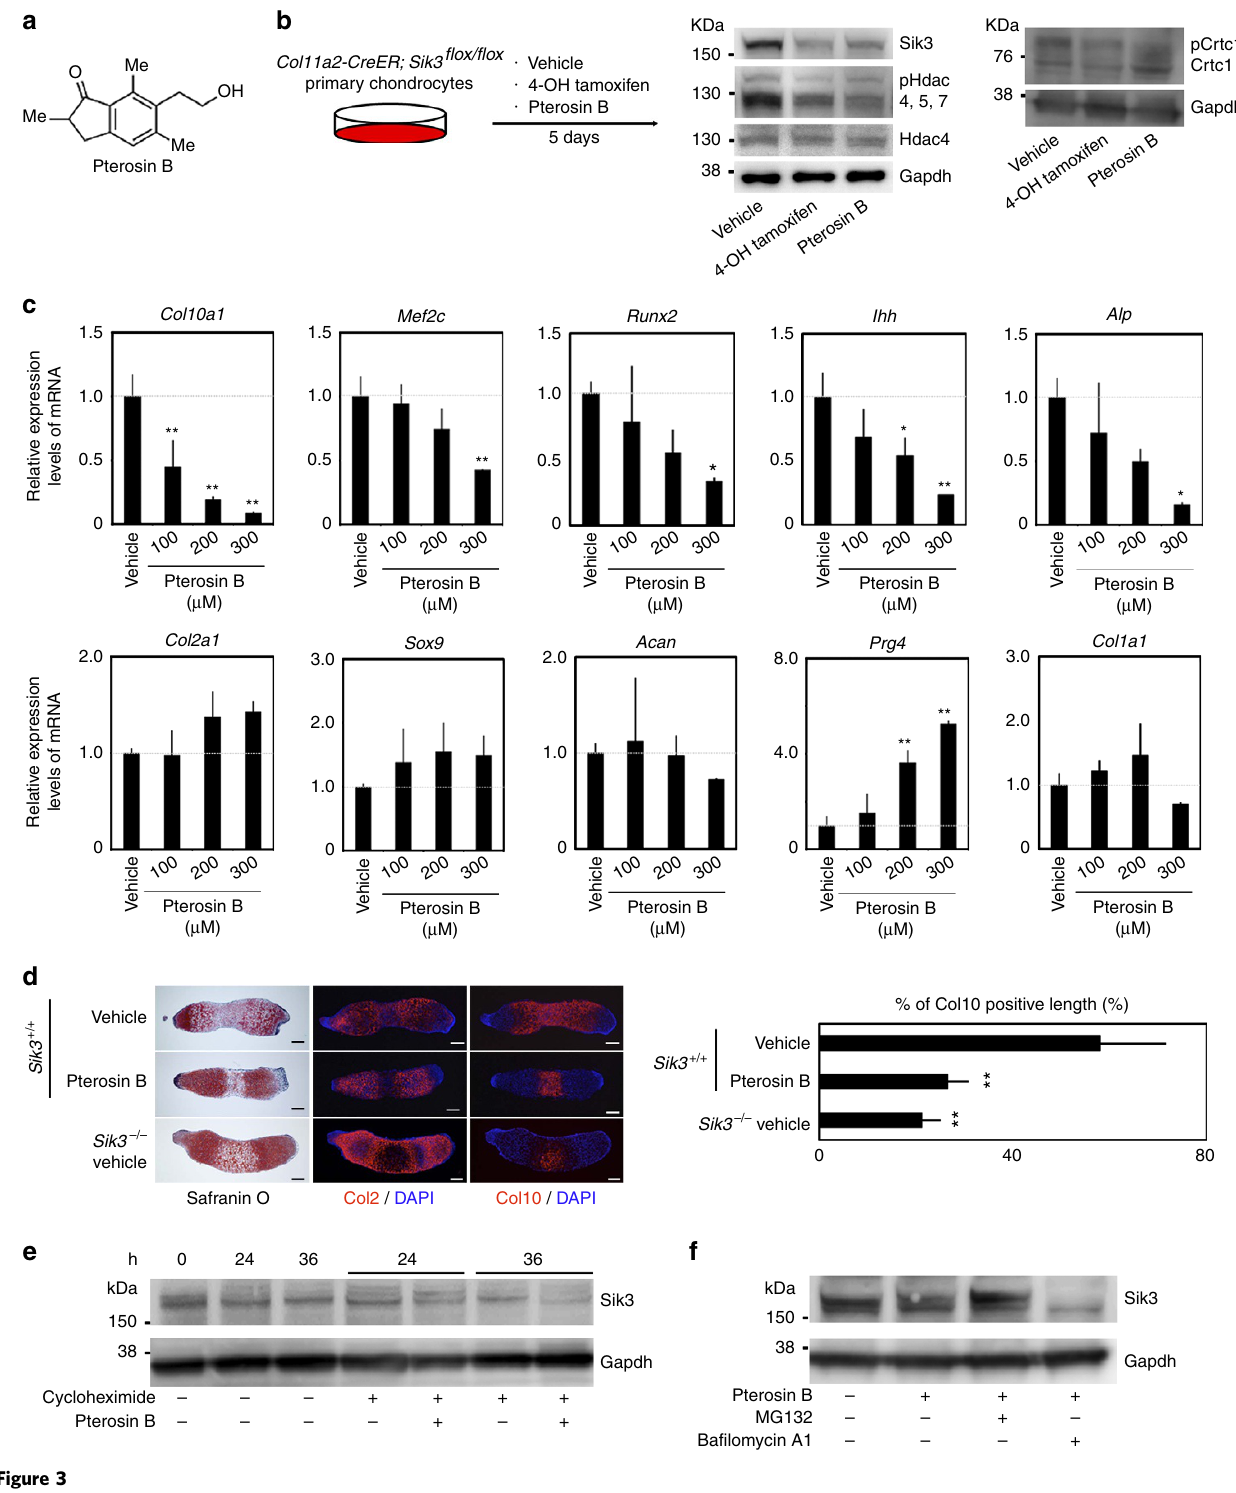
NATURE COMMUNICATIONS|7:12117|DOI: